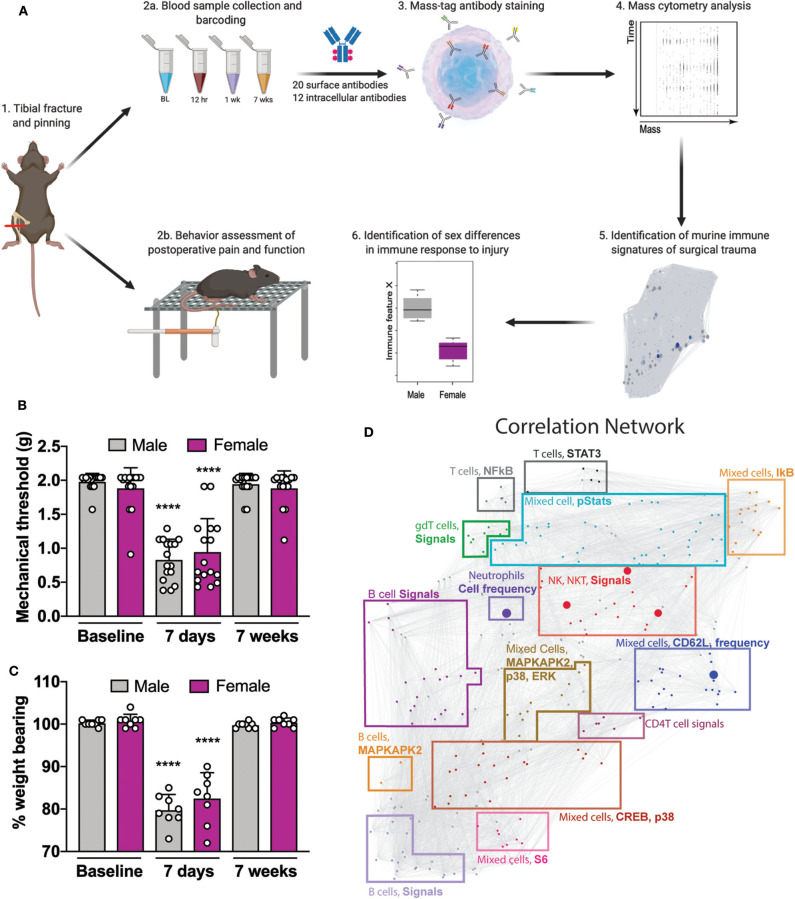
Experimental workflow and analytical approach to murine immune response after orthotrauma. (A) 1: Male and female mice underwent unilateral tibial fracture and pinning. 2a: A whole-blood sample was obtained at 4 time points BL, 12 h, 7 days, and 7 weeks. Samples were processed individually, barcoded for tracking purposes, and then pooled. 2b: Mice underwent behavioral assessment of postoperative pain and function through mechanical allodynia and weight bearing. 3: Aliquots were then used to quantify cell frequency and endogenous intracellular signaling activity. 4: Immune cells were stained with surface and intracellular antibodies and analyzed with mass cytometry. 5: Data obtained from mass cytometry were cross validated with an elastic net (EN) model predicting male or female at time of sampling. 6: Features that diverged between sexes were identified. (B) Decreased mechanical thresholds were noted 7 days after tibial fracture and pinning in male and female mice (n = 16 mice per group per sex, ****p < 0.0001 for 7 day threshold vs. respective sex baseline by one-way ANOVA, Tukey's post-test). (C) At 7 days post-injury both male and female mice placed less weight on the injured limb (n = 8 mice per group per sex, ****p < 0.0001 for 7 day % weight bearing vs. respective sex baseline by one-way ANOVA, Tukey's post-test). (D) Mass cytometry data formed a correlation network that visually segregated into 15 communities containing inter-correlated immune features that changed together during the injury recovery process. Communities are annotated based on immune feature attributes (cell type, signaling, or frequency) that are most frequently represented within each cluster. Individual data points are shown in addition to mean + SD for (B,C).